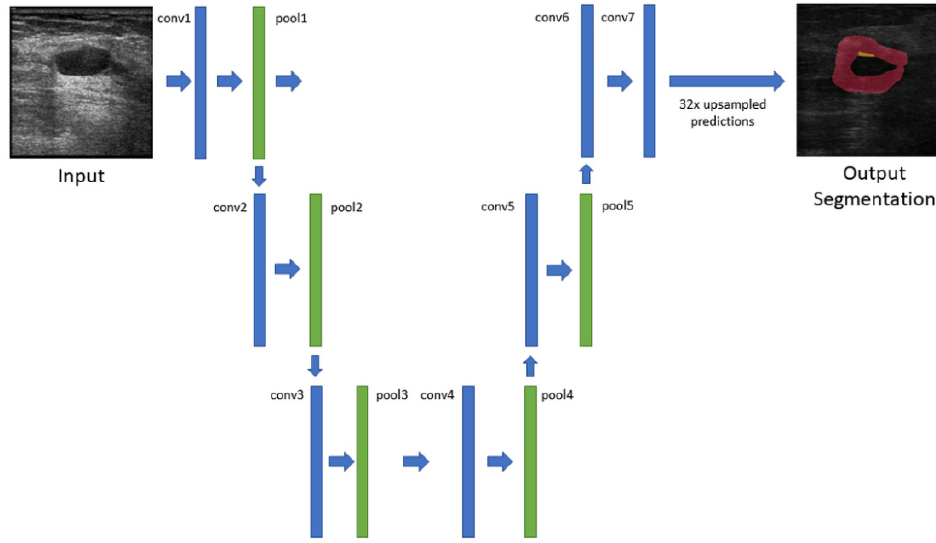
Figure 3. Network architecture of the fully convolutional network with 32× upsampled prediction.